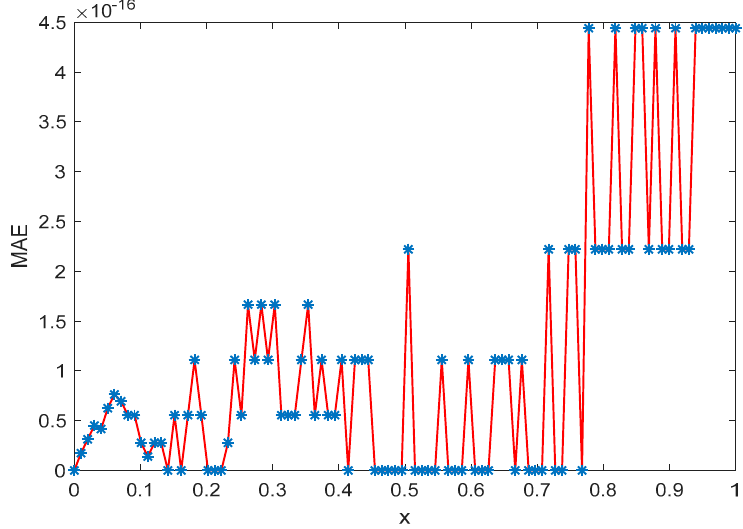
Figure 8. Plot of MAE of Example 4 for 𝛼 = (cid:2870)